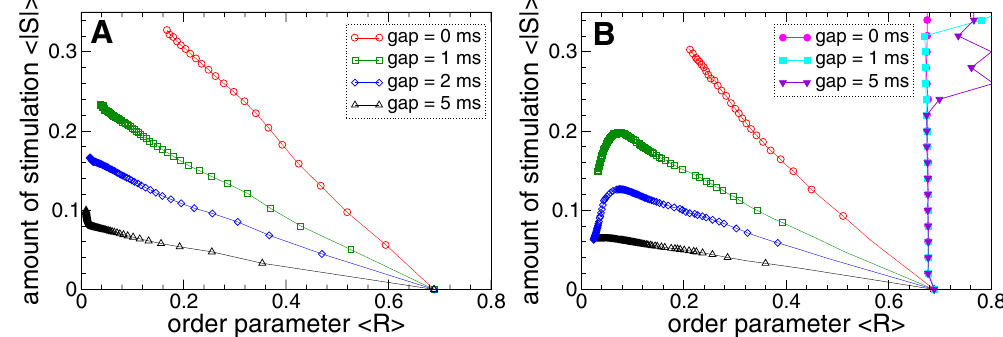
Figure 9. Efficacy of synchronization control in the neuronal ensemble (1) - (3) by the pulsatile LDF and NDF stimulations. The administered amount of the stimulation 〈 | S | 〉 is plotted versus the reached extent of desynchronization as given by values of the time-averaged order parameter 〈 R 〉 for ( A ) pulsatile LDF stimulation and ( B ) pulsatile NDF stimulation, where the amplitude of the stimulation pulses is modulated by delayed feedback signals (6) and (7), respectively. The width of the interphase gap is indicated in the legend in plot ( A ). Parameter of delay ( A ) τ = 70 ms and ( B ) τ = 150 ms. For comparison, in plot ( B ) the same quantities are depicted for the standard HF DBS (filled symbols) for the interphase gaps indicated in the legend. Note, desynchronization is achieved with standard HF DBS only at considerably greater amounts of stimulation, see Supplementary Fig.